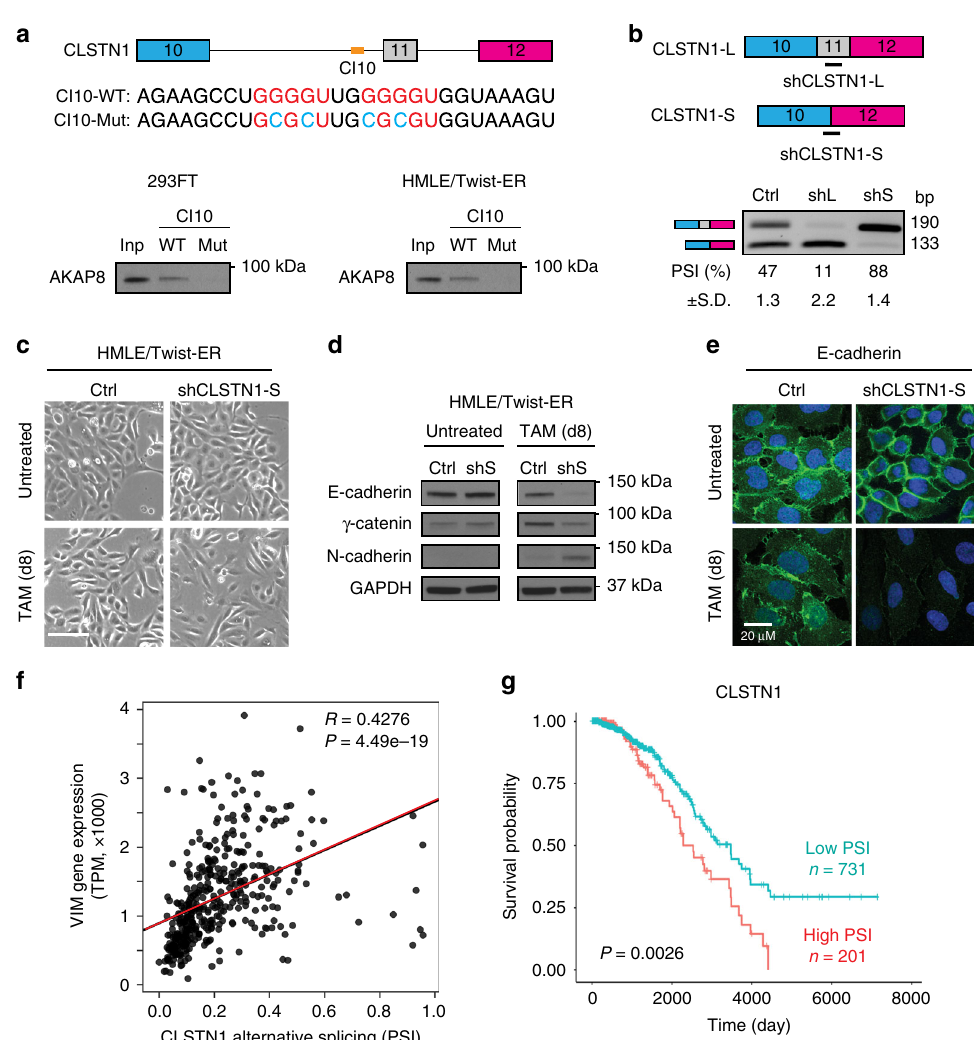
Fig. 7 The CSLTN1 isoform with exon 11 inclusion promotes EMT. a RNA pull-down assay showing that AKAP8 binds to the cis-element located in the intron upstream of CLSTN1 variable exon 11. A schematic of the CLSTN1 pre-mRNA and the cis-element sequence (CI10) are shown in the top panel. RNA pull down was performed using lysates from 293FT and HMLE/Twist-ER cells. Inp: Input. b A schematic of the location of CLSTN1 isoform-speci fi c shRNAs (black line, top panel), and semi-qPCR analysis (bottom panel) showing CLSTN1 isoform-speci fi c knockdown ef fi ciency in HMLE/Twist-ER cells. shL: CLSTN1-L knockdown; shS: CLSTN1-S knockdown. c Phase-contrast images (× 10) indicating accelerated cell morphology changes in control shRNA (Ctrl) and CLSTN1-S knockdown (shCLSTN1-S) cells 8 days after tamoxifen (TAM) induction. White line represents scale bar at 100 μ m. d Western blot analysis of EMT markers showing that CLSTN1-S silencing resulted in decreased expression of epithelial markers E-cadherin and γ -catenin and increased expression of the mesenchymal marker N-cadherin after 8 days of TAM induction. e Immuno fl uorescence images showing the loss of E-cadherin expression at cell junctions in the CLSTN1-S knockdown cells after 8 days of TAM treatment. f Plot of the mesenchymal marker vimentin (VIM) expression and CLSTN1 alternative splicing in the breast cancer TCGA data set showing a signi fi cant positive correlation in luminal breast cancer. PSI: Percent Spliced In. P value was determined by person correlation test. g Kaplan – Meier plot showing correlation between CLSTN1 alternative splicing, represented as PSI levels, and breast cancer patient survival in TCGA data set. The average PSI for the high group is 0.49 and low group is 0.15, which were determined by k -means clustering. P value was determined by log-rank test. Source data are provided as a Source Data fi